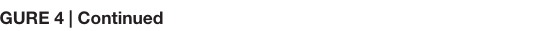
FIGURE 4 | Continued Expression of thalamic markers at embryonic stages 40/41. Microphotographs of transverse (A–E,G–I,K–M) or sagittal (F,J,N,O) sections of embryos at stages 40/41. In all cases, photographs correspond to combination of ISH (purple) with IHC (brown), except for a double fluorescent ISH (red) and IHC (green) panel (E) and two single ISH (purple; H,I) . The markers labeled are indicated in the upper left of each photograph. All images are oriented following the same standard: dorsal is upwards in transverse and sagittal sections, and rostral is to the left in sagittal sections. The neuromeric boundaries and main brain subdivisions are indicated to assist in the precise localization of the labeling. The levels of the transverse sections (A,K,L) are indicated in photograph (J) , the level of (G) is indicated in (F) , and the level of (M) is indicated in (N) . Scale bars = 50 µ m. See list for